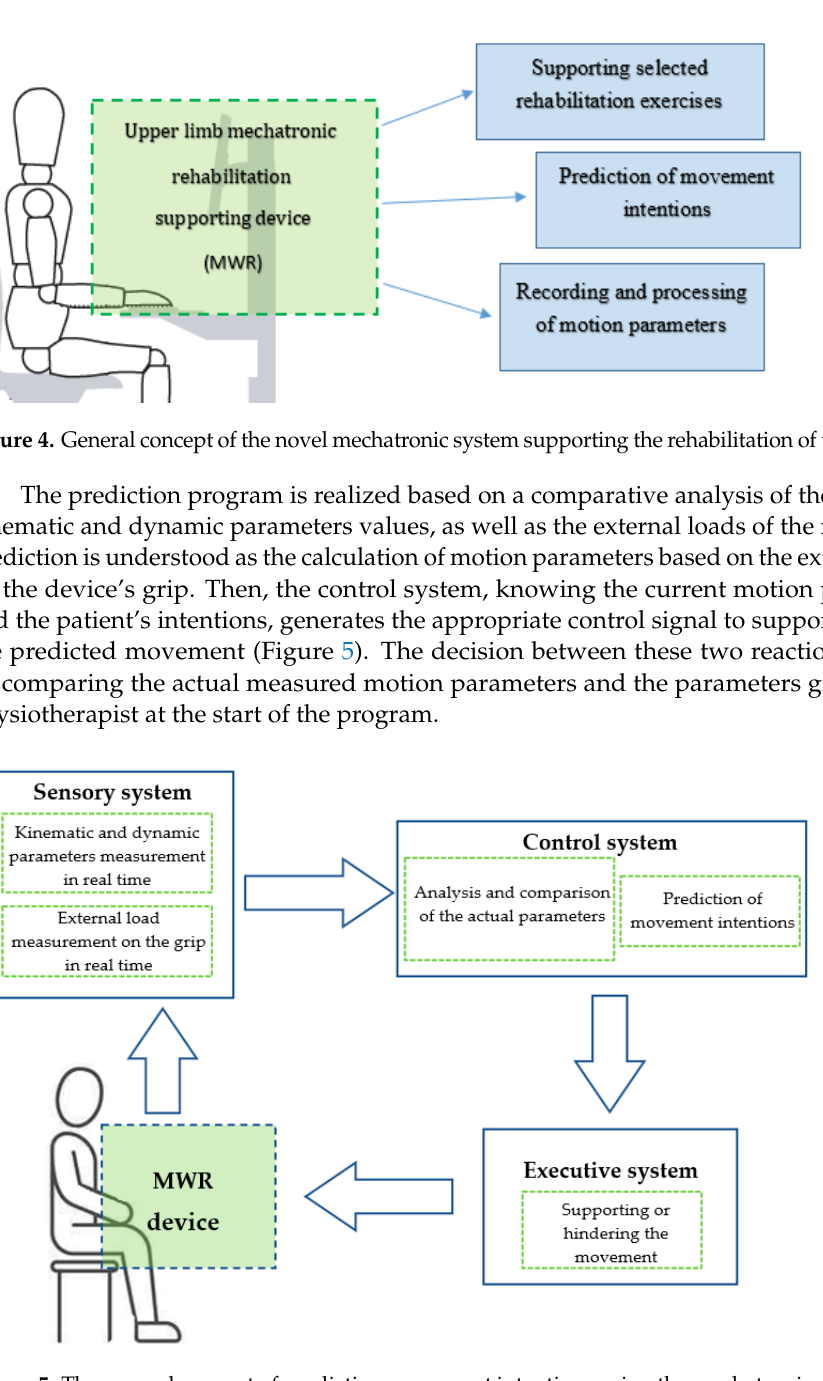
Figure 5. The general concept of predicting movement intentions using the mechatronic rehabilitation system (MWR) mechatronic system.